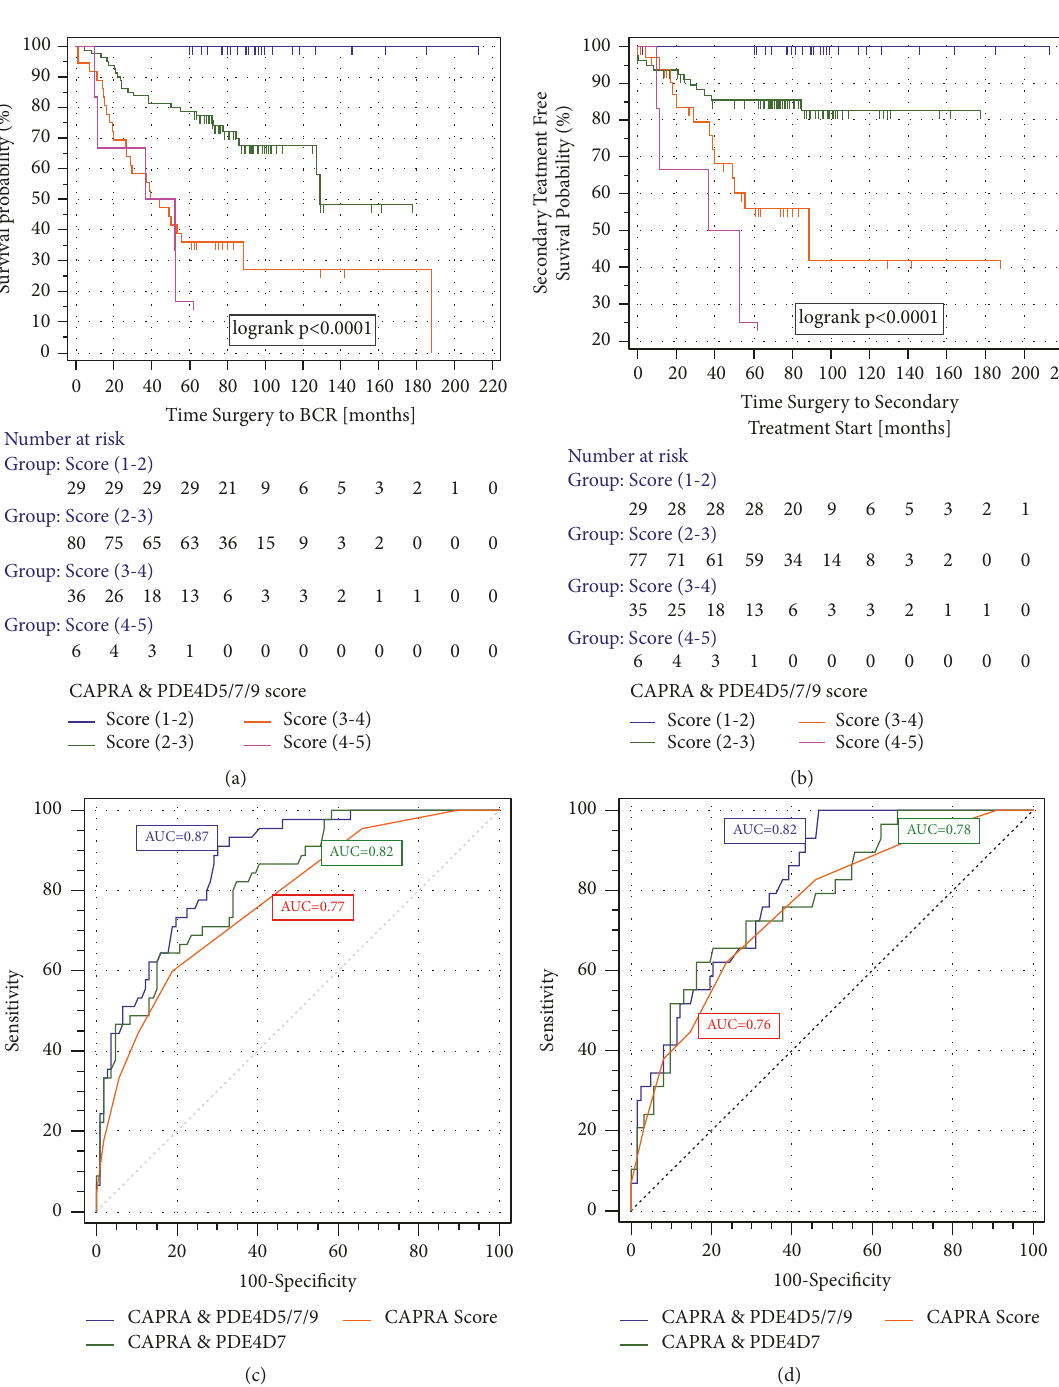
Figure 3: (a)Kaplan-Meieranalysis of the biochemicalrecurrence(BCR) freesurvivalinthe diagnosticbiopsy patient(DB)of the categorized CAPRA and PDE4D5/7/9 combination score. (b) Kaplan-Meier analysis of the postsurgical of secondary treatment free survival (STFS) time in the diagnostic biopsy patient (DB) cohort of the categorized CAPRA & PDE4D5/7/9 combination score. The CAPRA and PDE4D5/7/9 combination model was developed by logistic regression using data of the RP and RP patient cohort and used as such for testing in the DB patient cohort. The model score was transformed into a CAPRA & PDE4D5/7/9 score distribution between 1 and 5 equivalent to how the individual PDE4D transcript scores were generated [13]. Censored patients are indicated by vertical bars. PDE4D5/7/9 score categories were defined as PDE4D5/7/9 (1-2): PDE4D5/7/9 scores (1 to < 2); PDE4D5/7/9 (2-3):PDE4D5/7/9 scores (2to < 3); PDE4D5/7/9 (3-4):PDE4D5/7/9 scores (3 to < 4); PDE4D5/7/9 (4-5): PDE4D5/7/9 scores (4 to < =5). (c) ROC curveanalysis of 5-year biochemicalrecurrencein the DB cohort (n=151)of theCAPRA score(orange curve;AUC=0.77)vs. theCAPRAand PDE4D7 (greencurve;AUC=0.82) vs.the CAPRA& PDE4D5/7/9 (blue curve; AUC=0.87) logistic regression models. (d) ROC curve analysis of 5-year postsurgical secondary treatment free survival in the DB cohort (n=151) of the CAPRA score (orange curve; AUC=0.76) vs. the CAPRA and PDE4D7 (green curve; AUC=0.78) vs. the CAPRA and PDE4D5/7/9 (blue curve; AUC=0.82) logistic regression